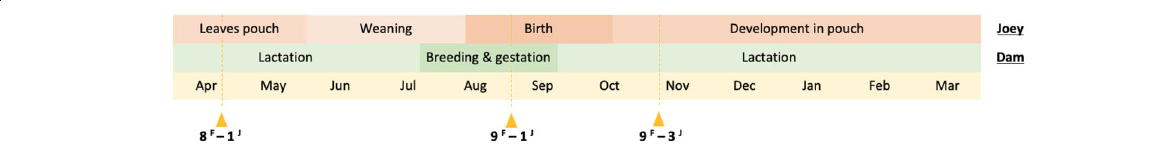
Fig. 1 Timeline of the three field trips in relation to the typical reproductive cycle of female SHNWs and the developing young. Note that these reproductive timelines are averages, and that some variation can occur due to rainfall/food availability. Arrows indicate when the field trip took place, and the numbers indicate the number of female wombats ( F ) and joeys ( J ) caught and sampled